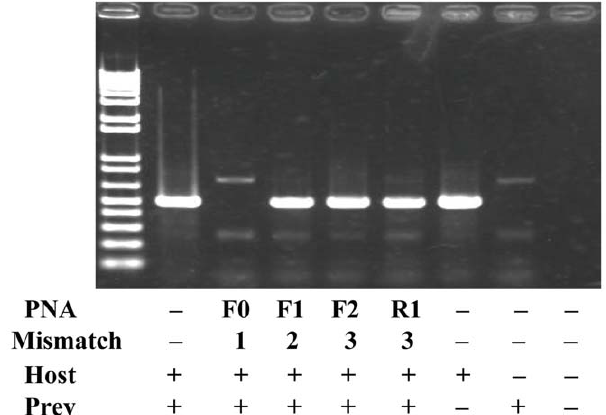
Figure 4. A result of PNA-directed PCR clamping using a mixed DNA template from a variant type clone (eel01-01) and spiny lobster. PNA-F0 (one mismatch) successfully inhibited amplification of eel ITS1 but did not inhibit amplification of lobster ITS1 (3 rd lane from the left), while the other PNAs (having two to three mismatches) failed to inhibit amplification of eel ITS1 (4 th to 6 th lane from the